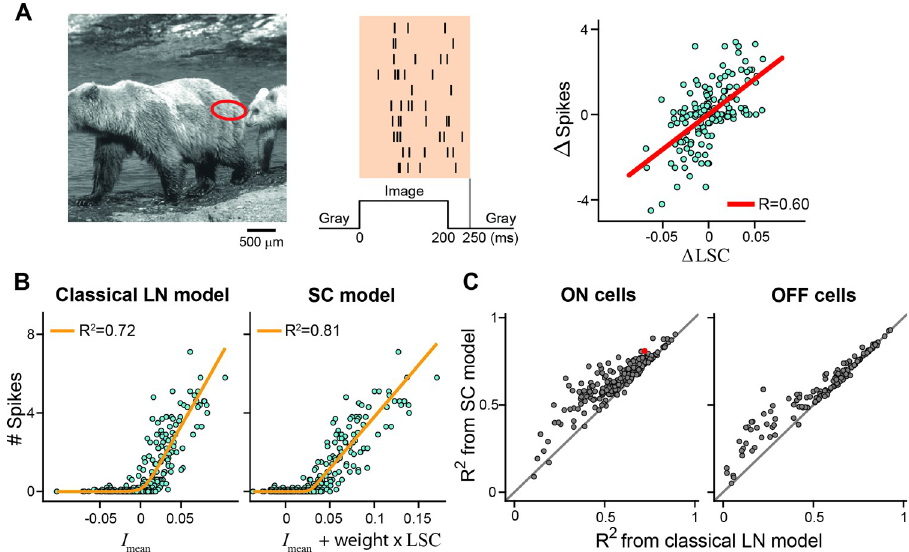
Fig 5. Analysis of a dataset of mouse retinal ganglion cells. A) Receptive field center (3-sigma contour, red ellipse) of a mouse ganglion cell, overlaid on a sample image (left), spiking responses of the cell to the sample image for ten trials (center), and the cell’s spike-count differences versus differences in local spatial contrast for pairs of images with nearly equal mean luminance information in the receptive field (right, N = 299 image pairs). B) Scatter plots of spike count versus the linear signals of the LN model (left) and of the SC model (right) for all 300 images for the sample cell of A. The orange lines show the nonlinearities, fitted on the 150 training images, with the stated coefficients of determination ( R 2 ; obtained from the 150 test images) used as evaluation of the fit quality. C) R 2 compared for the classical LN model and the SC model, separately for mouse ON ganglion cells (left) and OFF ganglion cells. The data from the sample cell is marked in red. N = 206 ON and 142 OFF cells from 9